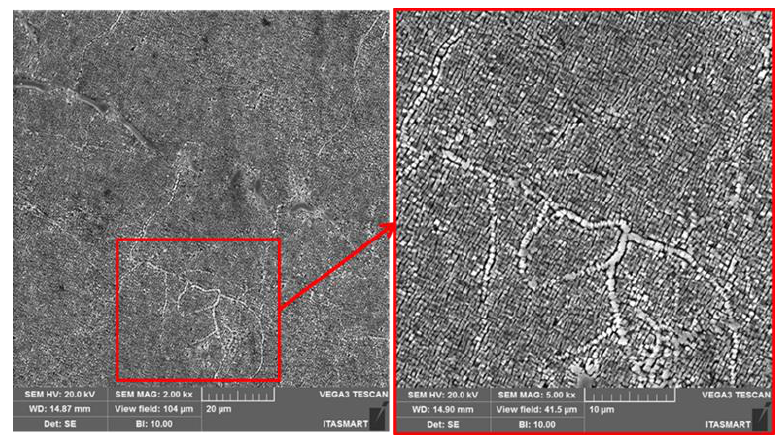
Figure 6. SEM of the stabilization heat treated condition.